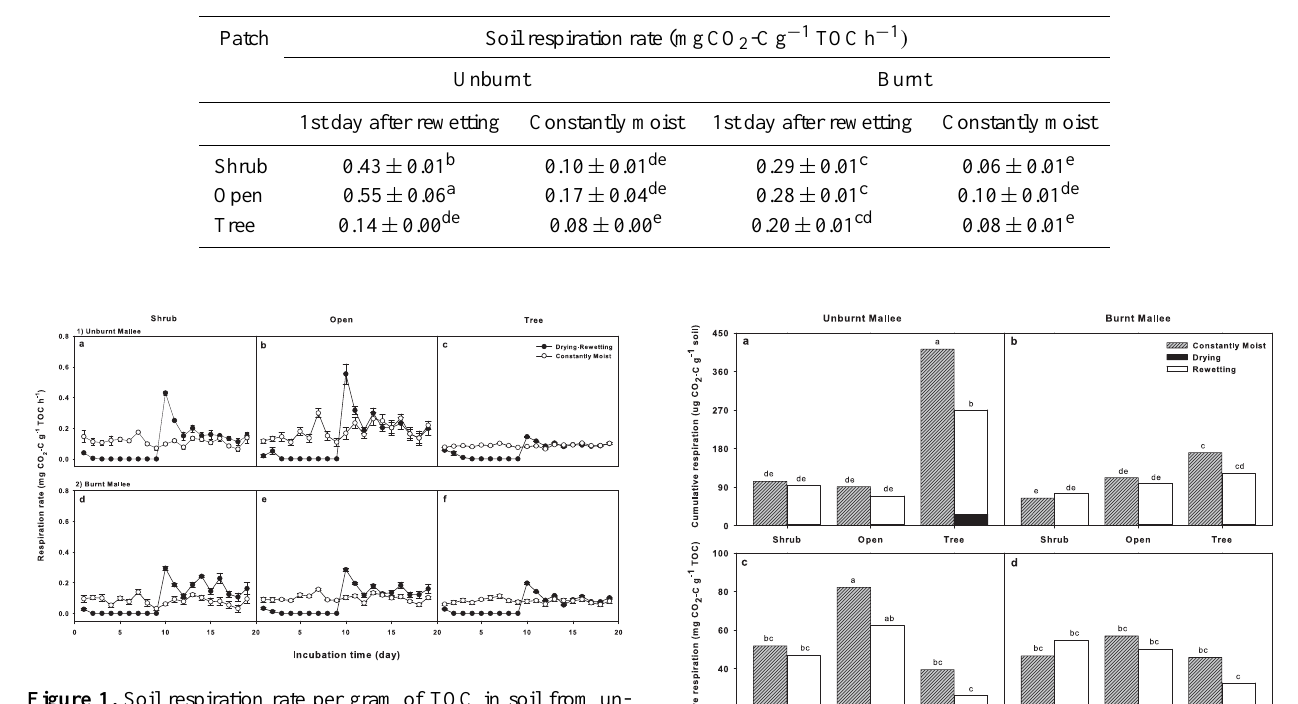
Figure 1. Soil respiration rate per gram of TOC in soil from un- der shrubs (a, d) , in open areas (b, e) and under trees (c, f) and of unburnt (a–c) and burnt (d–f) mallee woodlands under constantly moist and dry–rewetting treatments (mean ± standard error, n = 4).